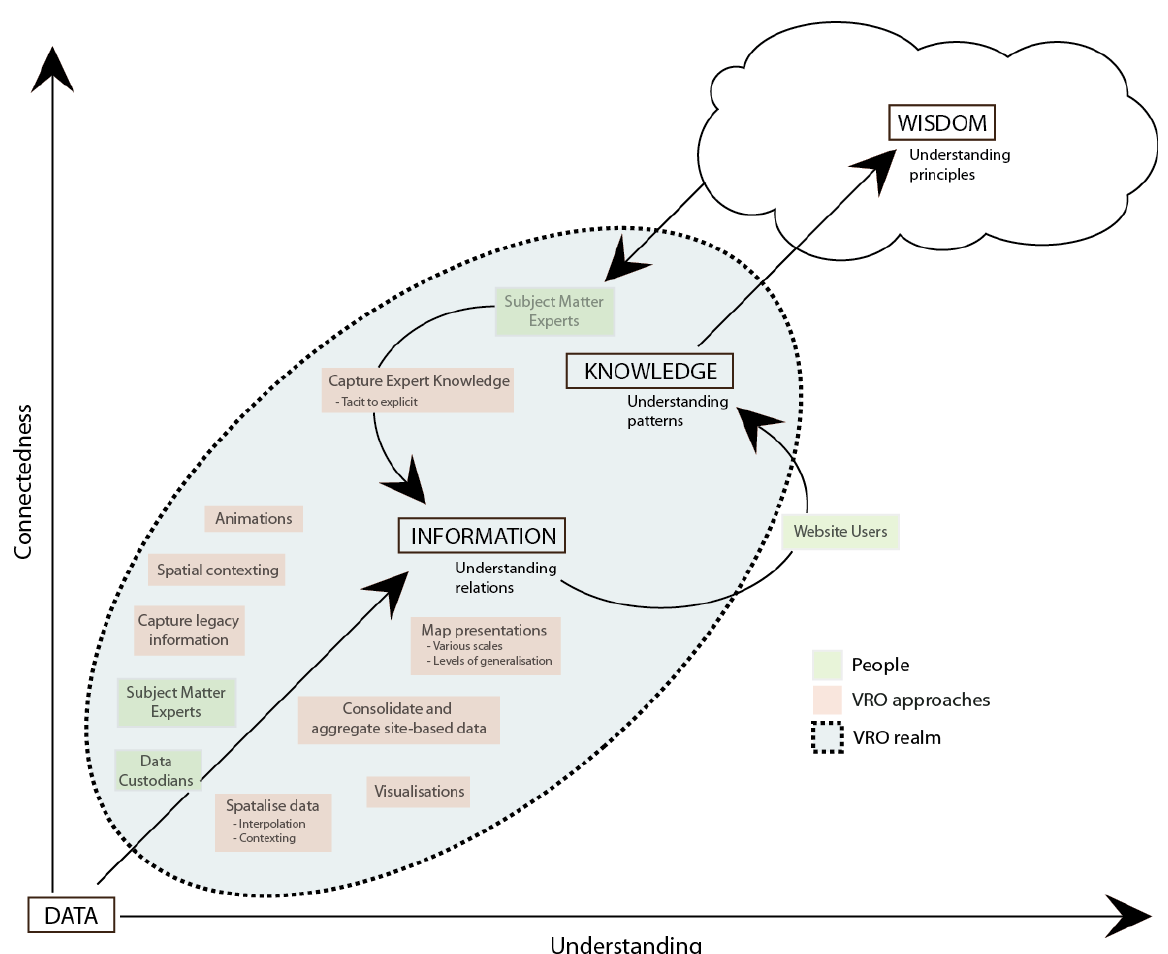
Figure 5. An adapted data-information-knowledge-wisdom (DIKW) progression proposed by Bellinger et al . (2004) incorporating people and approaches within the VRO